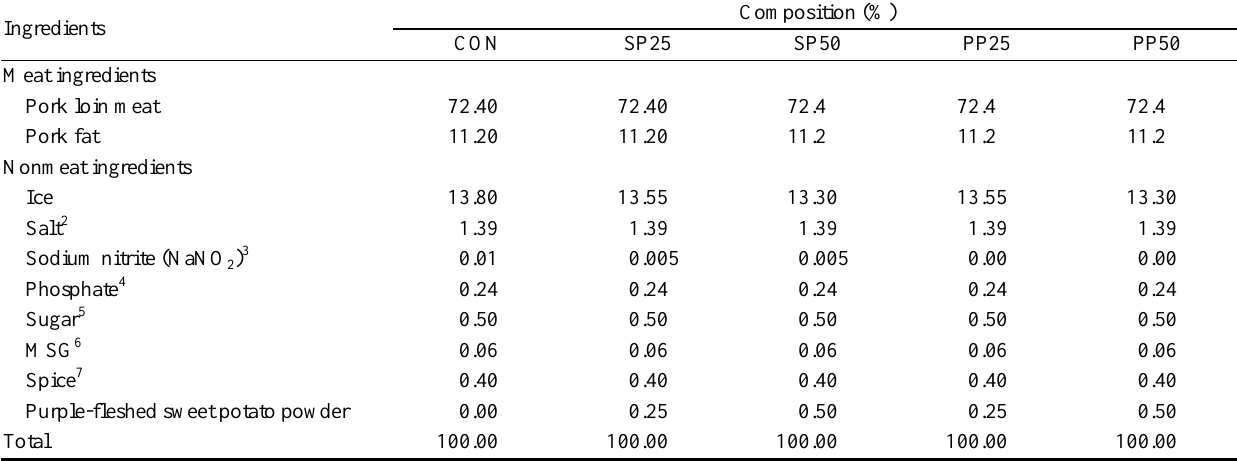
Table 1. Composition of cooked pork sausage blends